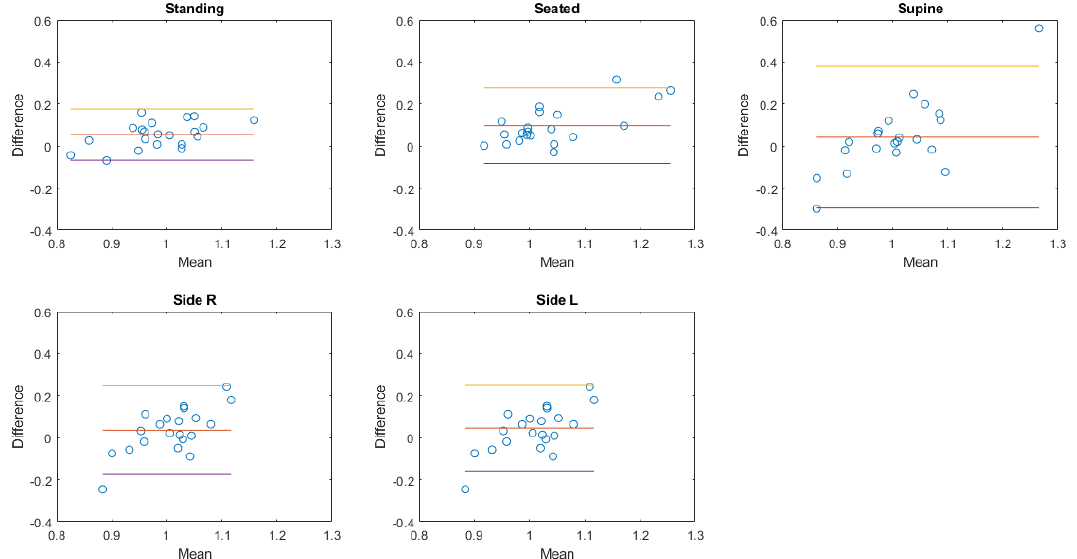
Figure 13. Bland-Altman plots of the aggregated results of normalized amplitude at rest. Each dot represents the value obtained from a single subject. The yellow line represents the upper limit of agreement (mean error + 1.96 × standard deviation); the red line represents the mean error; the purple line represents the lower limit of agreement (mean error − 1.96 × standard deviation).